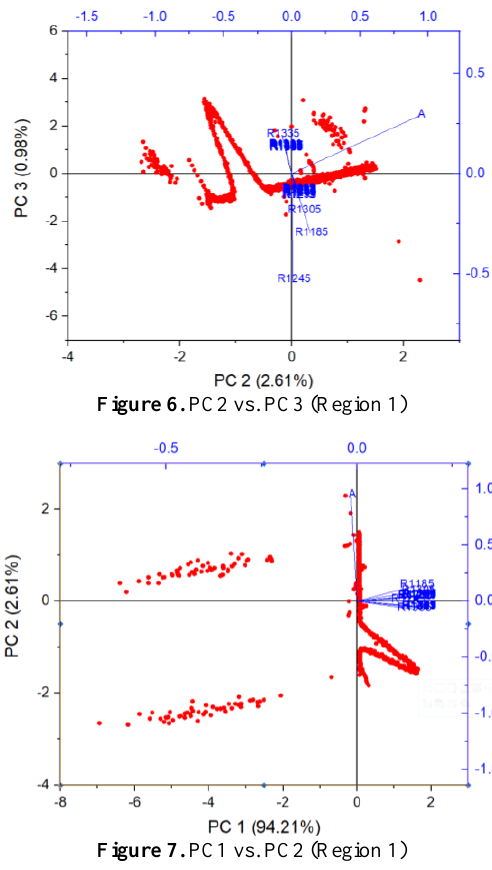
Figure 7. PC1 vs. PC2 (Region